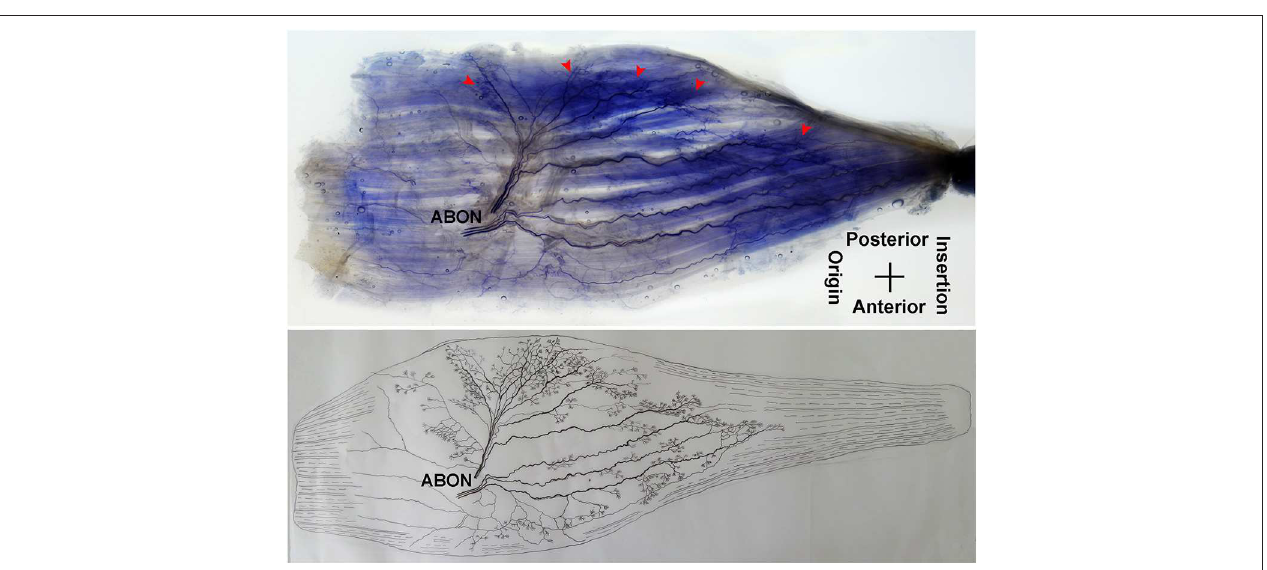
FIGURE 7 | Distribution of intramuscular nerves in the gracilis (left, deep side). The arrowhead indicates the claw-like and tree-like terminal nerve distribution (ABON, anterior branch of the obturator nerve).